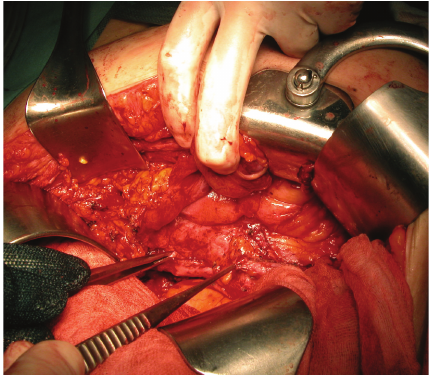
Figure 3: Intraoperative measurement of the ureteral defect length outlined by two forceps.